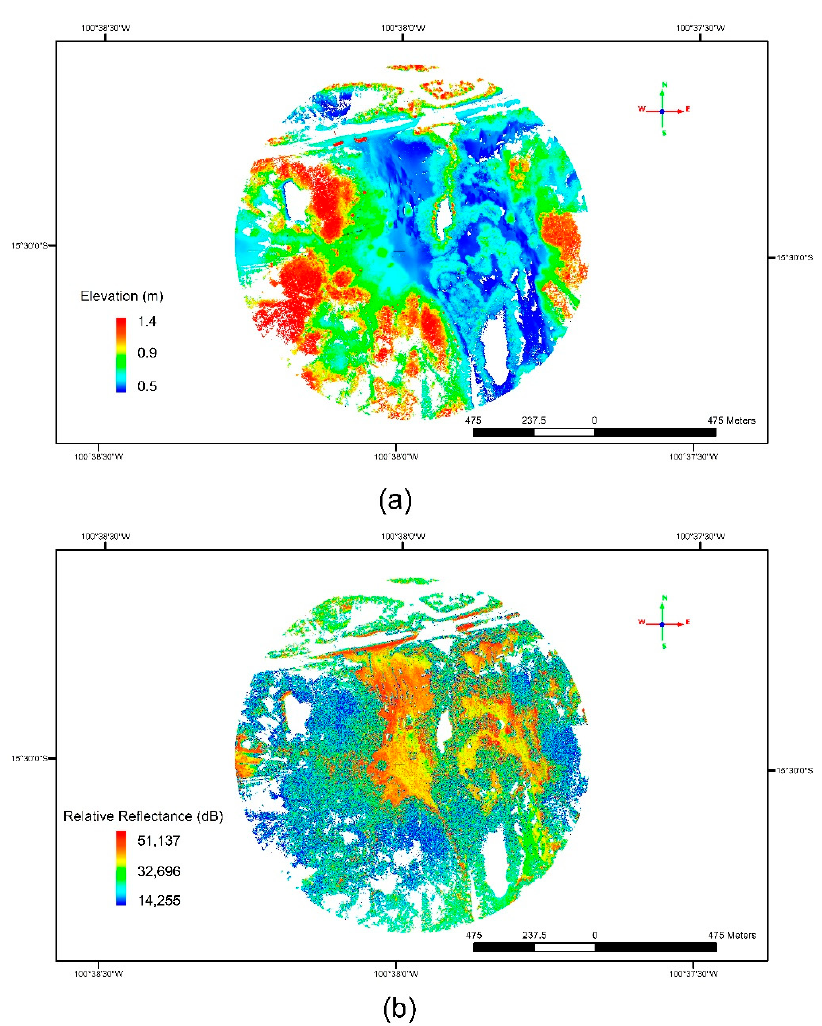
Figure 2. Terrestrial Laser Scanning (TLS) merged point cloud colored by ( a ) elevation and ( b ) relative reflectance.